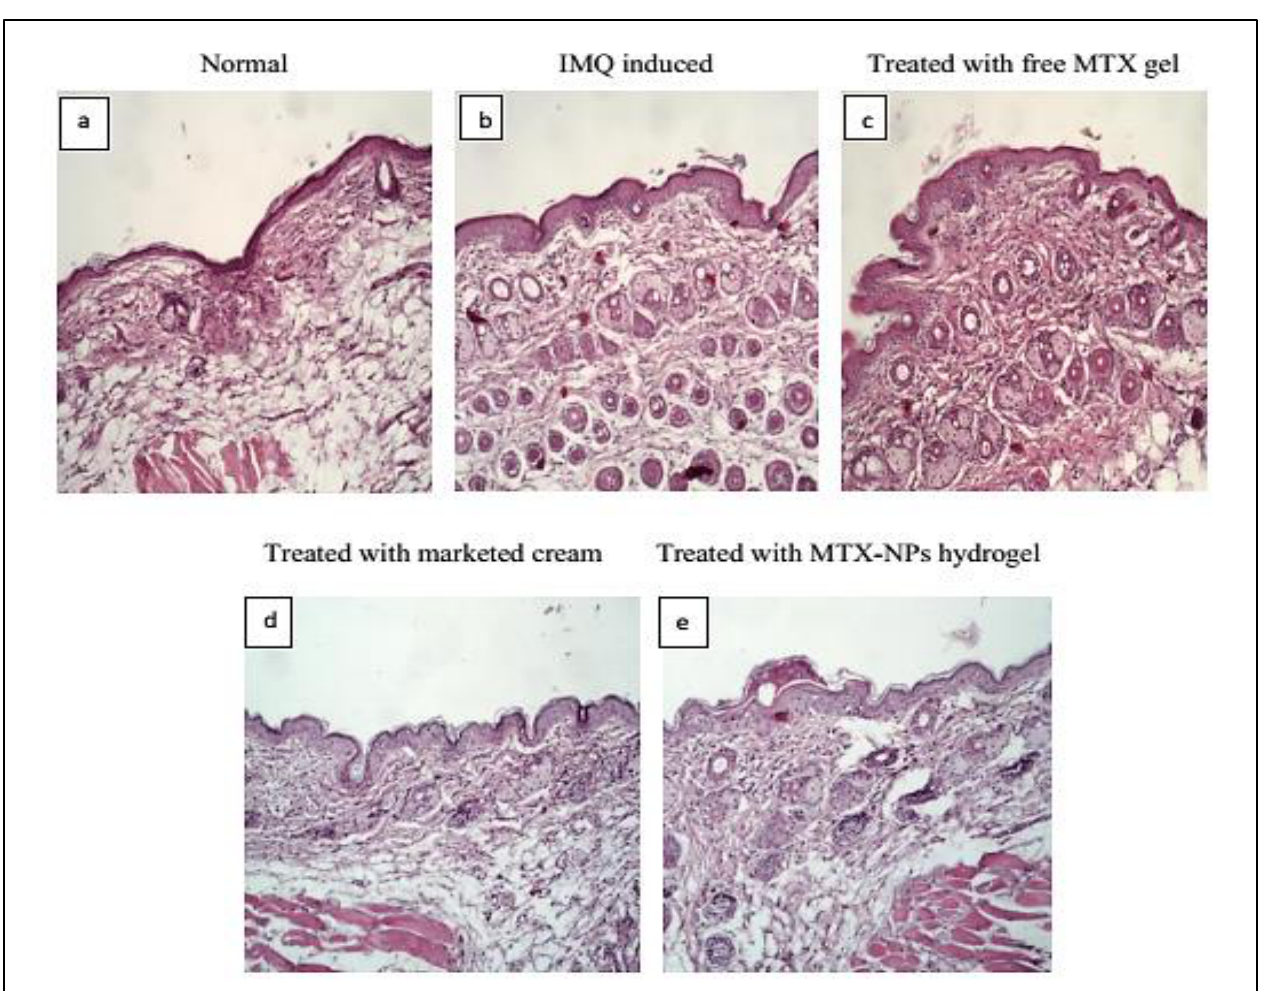
Figure 11. Histopathology of BALB/c mice skin after 10 days of topical treatment ( a ) Normal ( b ) IMQ induced ( c ) Treated with free MTX hydrogel ( d ) Treated with marketed cream ( e ) treated with MTX - NPs loaded hydrogel.